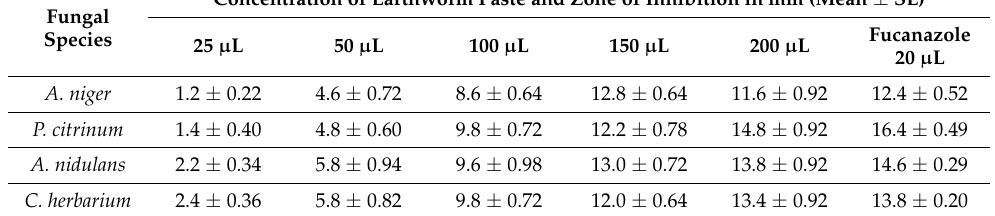
Table 5. Efficiency of earthworm paste against fungal pathogens (adopted from Senthil and Sivakami, 2018)